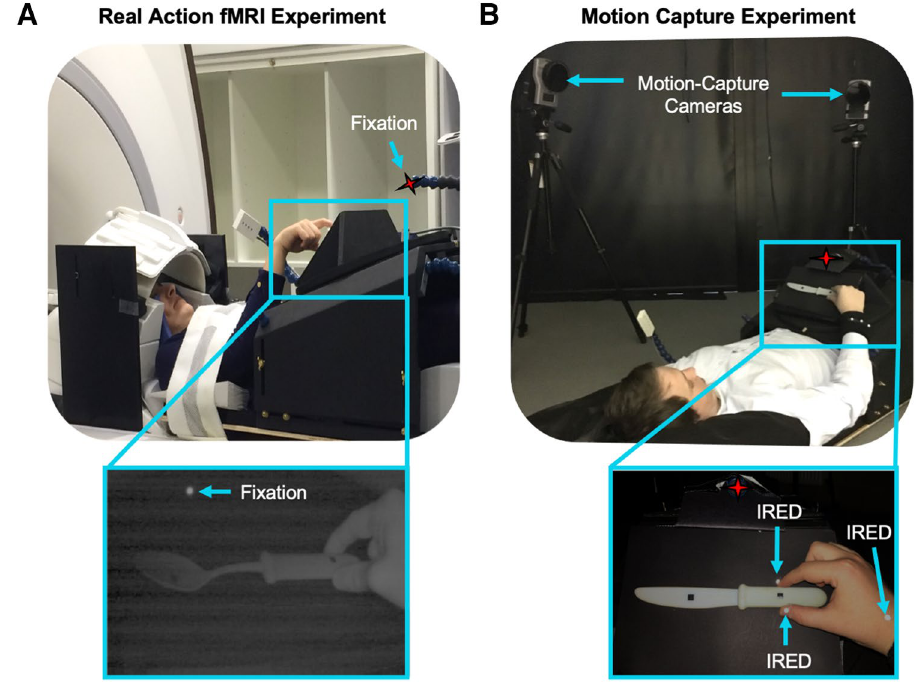
Figure 1. ( A ) fMRI Experiment . Participants laid under a custom-built MR-compatible turntable where 3D-printed tool and non-tool stimuli were presented within reaching distance in a block-design. ( B ) Motion- Capture Experiment . As a behavioural control experiment, participants performed this paradigm in a motion- capture laboratory to measure kinematics with infrared-reflective (IRED) markers affixed to the hand. ( A and B ) During the experiments, the rooms were completely dark, objects were visible only when illuminated, all actions were performed with the right-hand only and participants were naïve to study goals (i.e., they were asked to grasp right or left side of objects without mentioning we were investigating tools or typicality